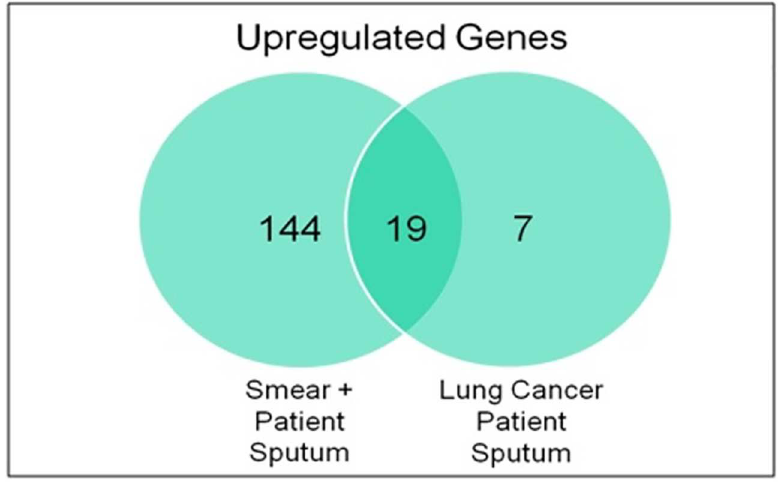
Fig 2. Venn diagram indicating overlap of M . tb genes detected as upregulated in sputum in TB patients and in sputum from lung cancer patients. 163 geneswere upregulatedin sputum from PTB patients and 26 genesalso showedupregulation in sputum from lung cancer patients out of which 19 genes were common betweenthe two and hencewere eliminated from the list of